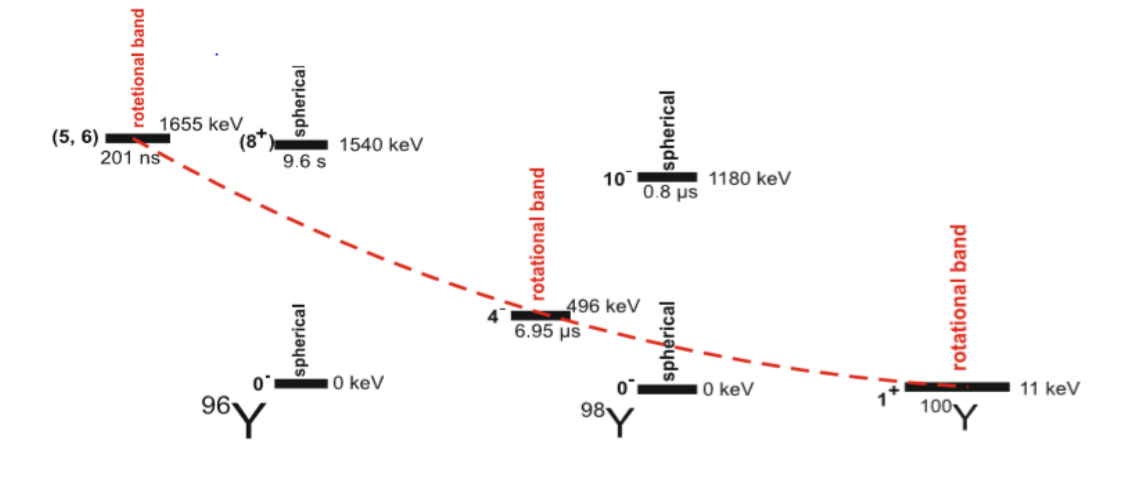
Fig. .2 . Pictorial drawing of the evolution of deformed structures (in red) across the Y isotopic